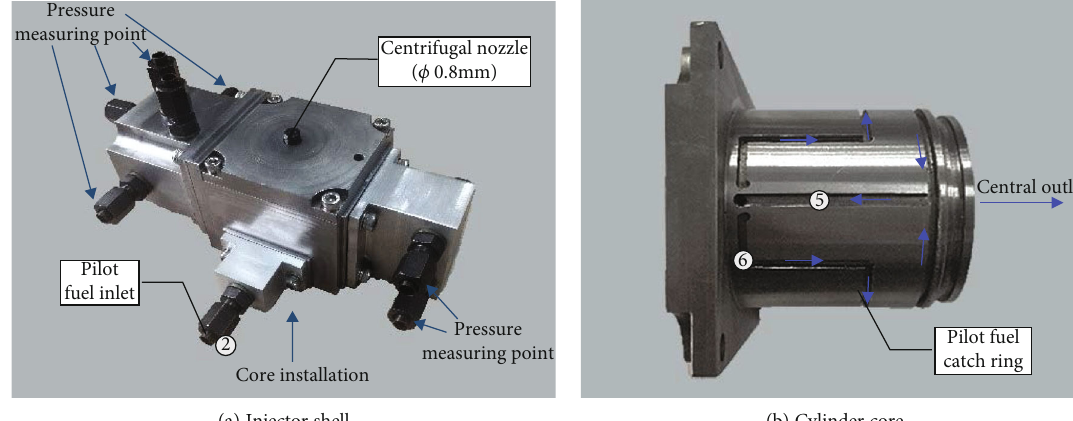
Figure 5: Test piece of main fuel path.